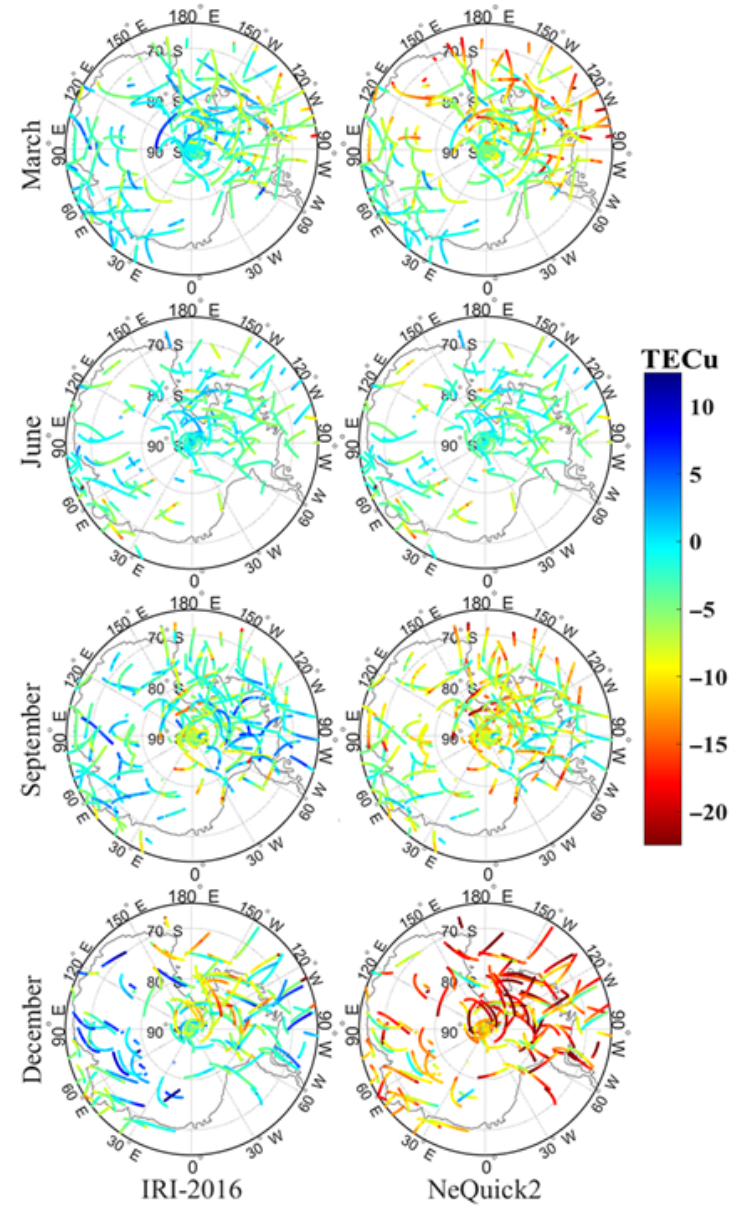
Figure 4. Distribution of difference of STEC (dSTEC) of the International Reference Ionosphere-2016 and NeQuick2 models at 2:00 UT during the experiment